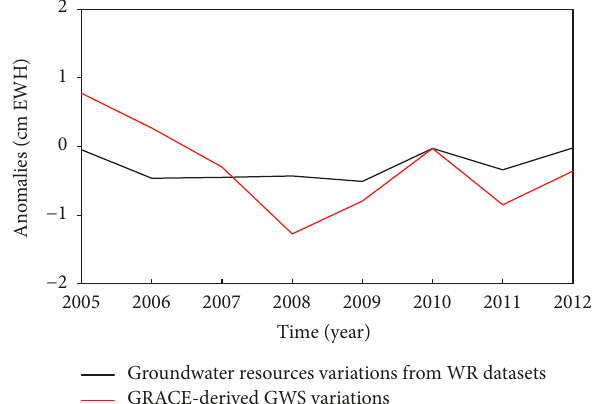
Figure 3: Comparison of the annual changes in groundwater resources from the WR datasets and GRACE-derived GWS varia- tions of the Northern China from 2005 to 2012.